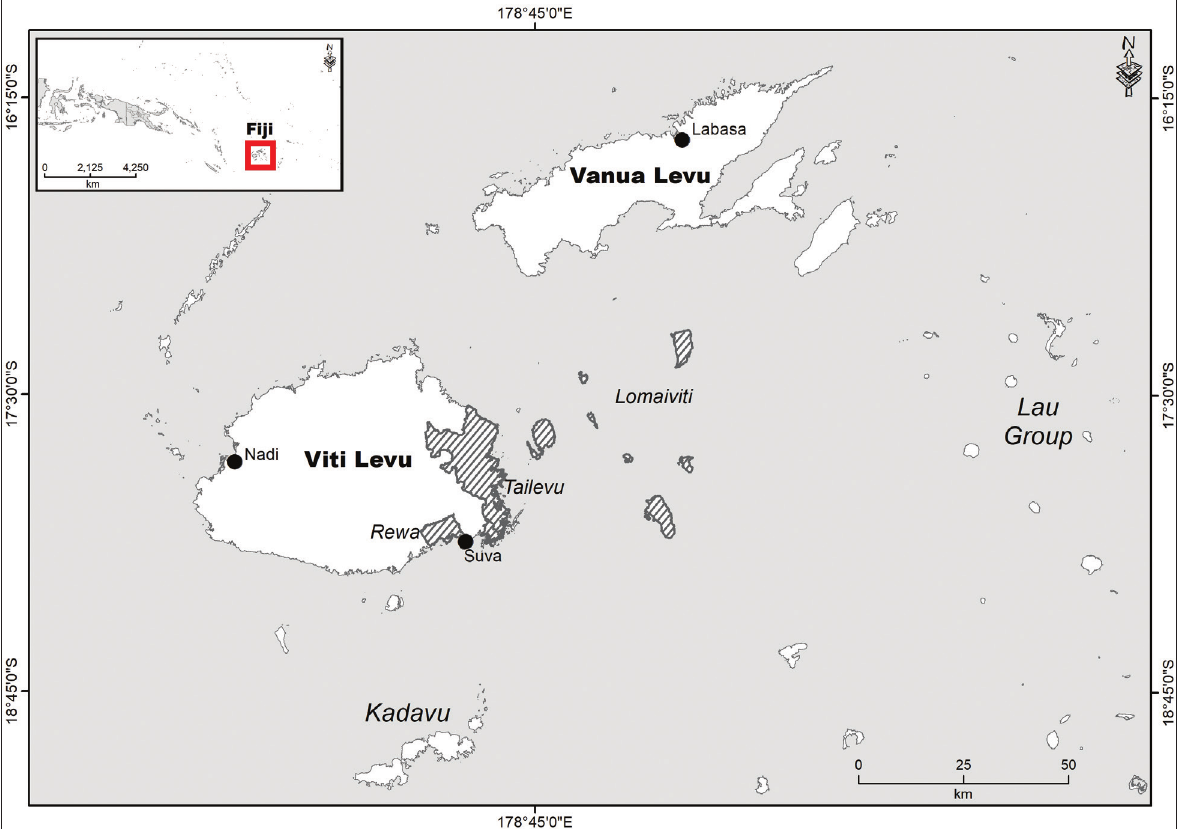
Figure 1. Map of the Republic of Fiji. Specimens were obtained in Labasa from fish-market vendors and from individual fishers. Additional specimens, also originating from the northern island of Vanua Levu, were purchased from vendors at Bailey Bridge market in Suva. Shaded areas represent locations referenced in the description of market survey